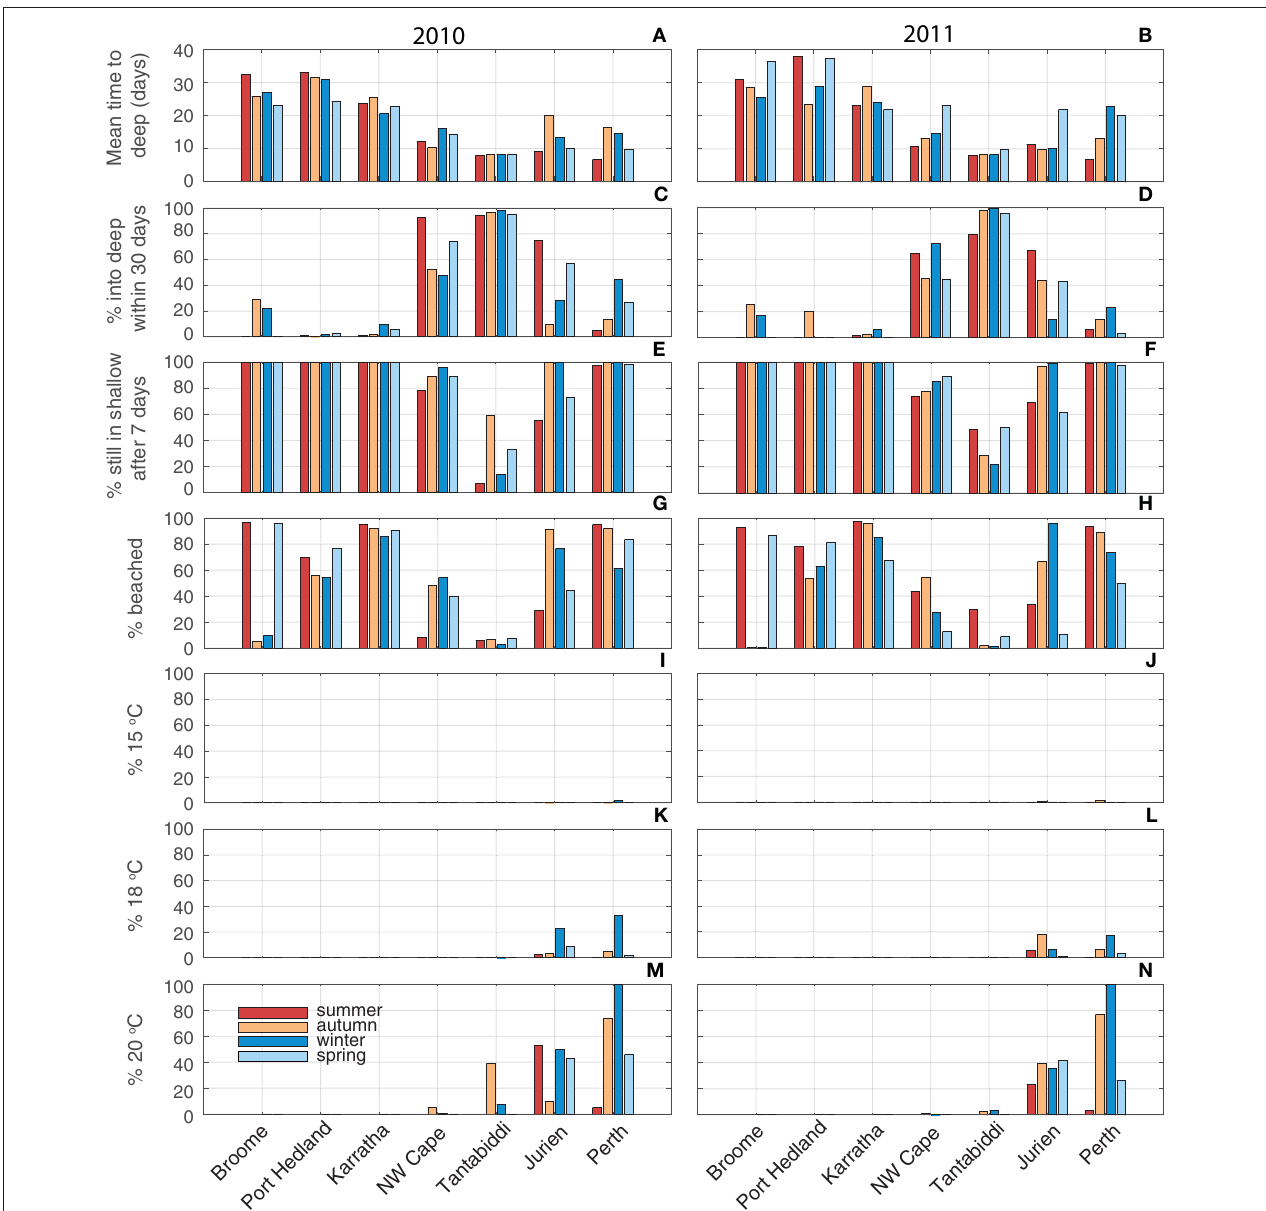
FIGURE 5 | Proportions of particles fulfilling each criteria used to determine success, including 2010 and 2011 seasonal averages for seven sites of (a,b) mean time in days for particles to reach the edge of the continental shelf ( > 130m depth); (c,d) proportion of particles that drifted into deep water ( > 130 m) within 30 days—if so, flatback species were unsuccessful; (e,f) proportion of particles that were still in shallow water ( < 130 m) after 7 days—if so, deep water species were unsuccessful; (g,h) proportion of particles that beached resulting in failure for all species; (i–n) proportion of particles experiencing temperature thresholds of 15, 18, and 20 ◦ C relevant to each corresponding